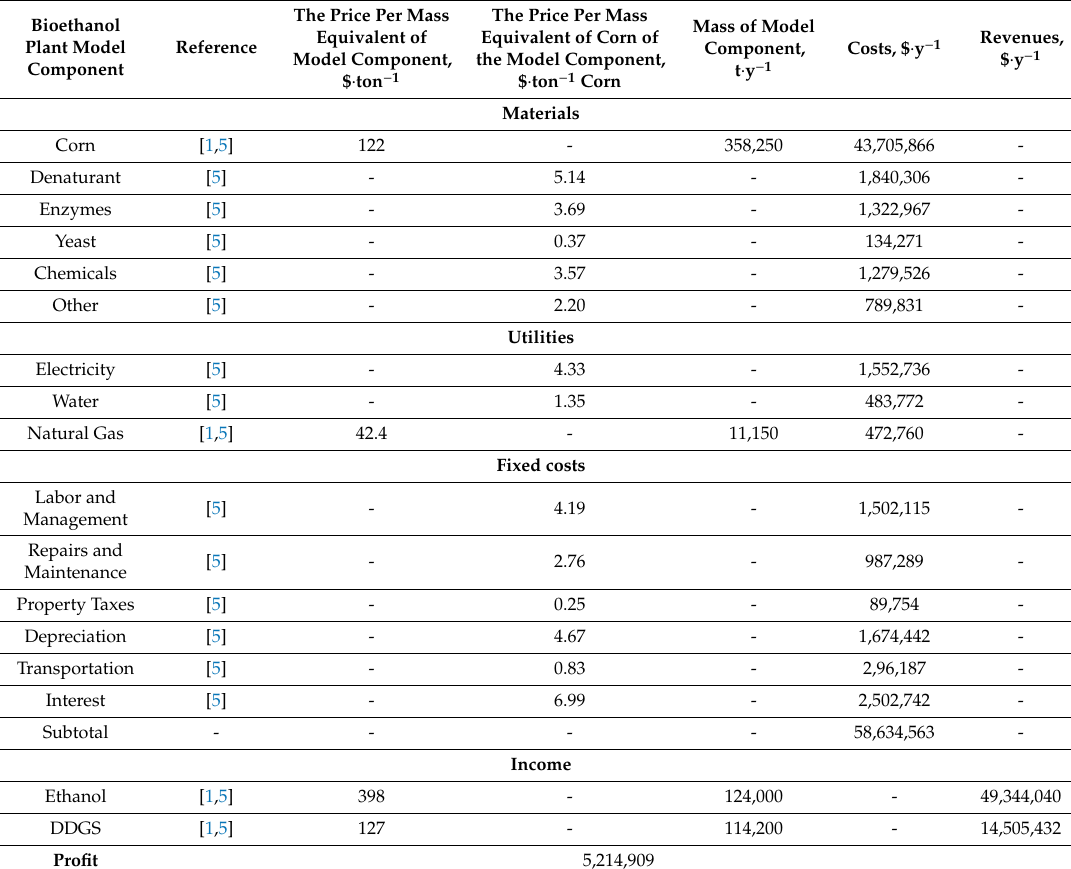
Figure 2. Information provided in the ‘Cleaning’ page from the Supplementary Material (Excel spreadsheet, Technoeconomic Model). Table 2. The economic analysis of the conventional bioethanol plant on the basis of the mass balance of the main components and